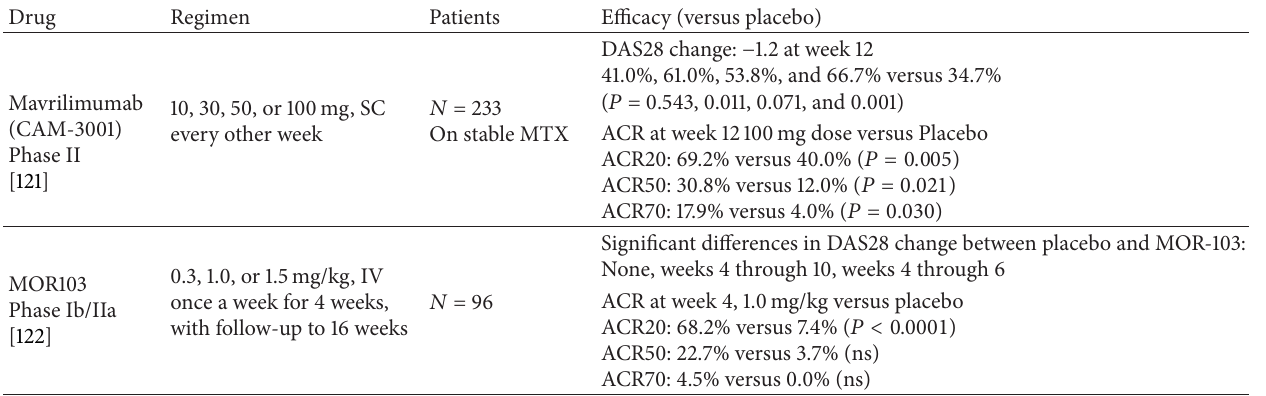
Table 2: Effects of GM-CSF inhibitors in